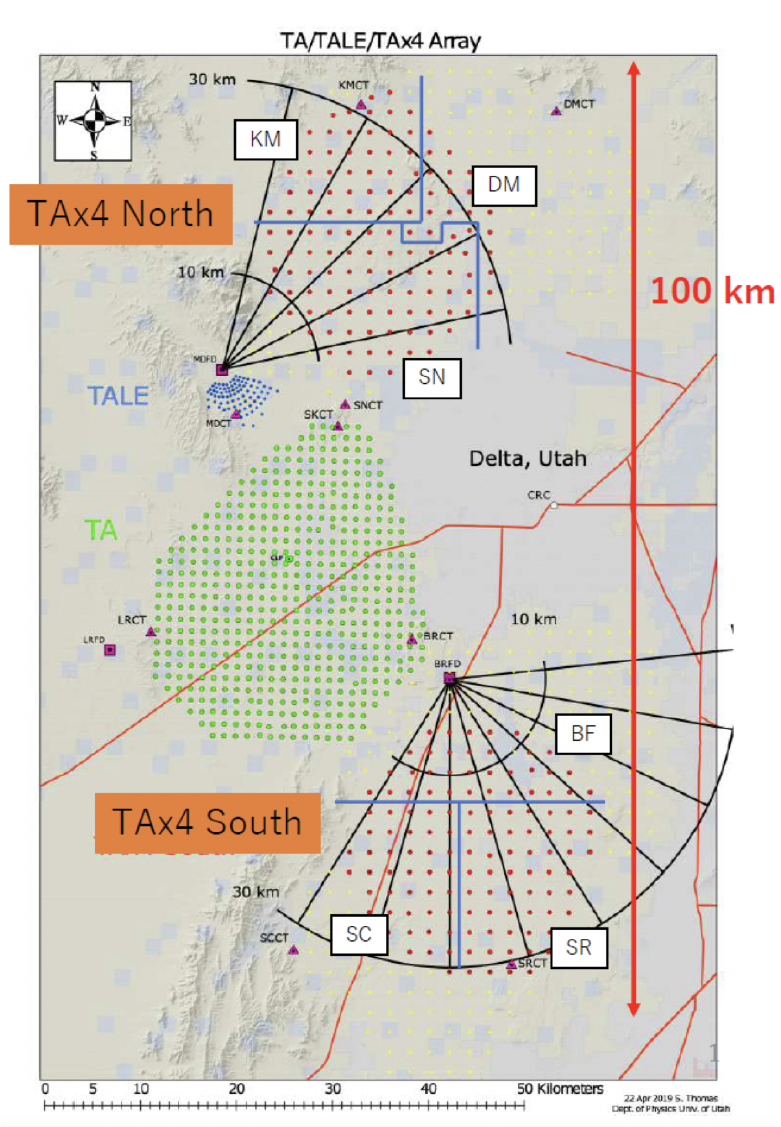
Figure 1: Map of the configuration of TAx4 experiment. The red circles represent the location of the deployed TAx4 SDs. The TAx4 northern array consists of 3 sub-arrays (KM, DM and SN). The TAx4 southern array also consists of 3 sub-arrays (BF, SC and SR). The blue lines represent the borders of TAx4 sub-arrays. The green circles and the blue circles denote TA SDs and TALE SDs